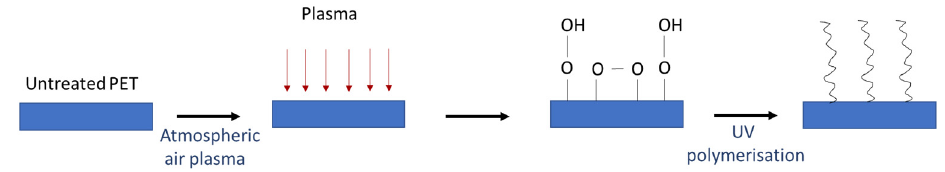
Figure 5 . Proposed mechanisms for the atmospheric plasma treatment and the UV grafting Figure 5. Proposed mechanisms for the atmospheric plasma treatment and the UV grafting polymeri- polymerisation of the acrylates on the PET surface. sation of the acrylates on the PET surface.